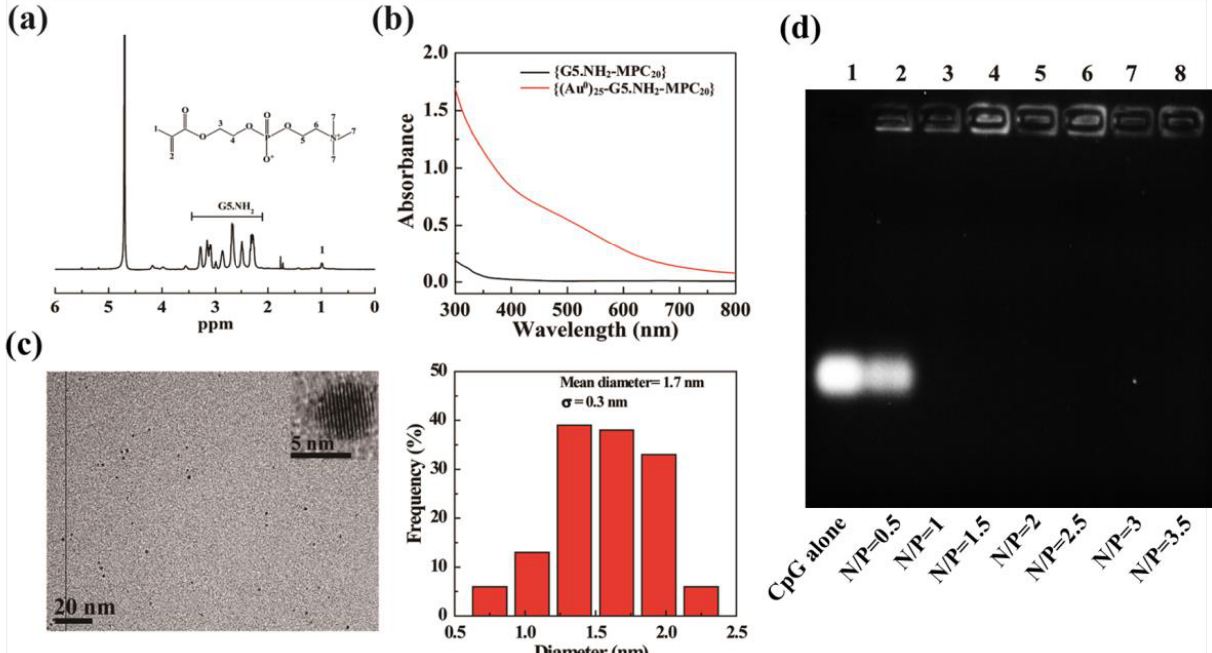
Figure 1. ( a ) 1 H-NMR spectrum of Au DENPs-MPC. ( b ) UV/Vis absorption spectra of {G5.NH 2 -MPC 20 } and Au DENPs-MPC. ( c ) TEM image and size distribution histogram of Au DENPs-MPC. ( d ) Agarose gel electrophoresis of Au DENPs-MPC/CpG-ODN complexes at different N/P ratios (range from 0.5~3.5).